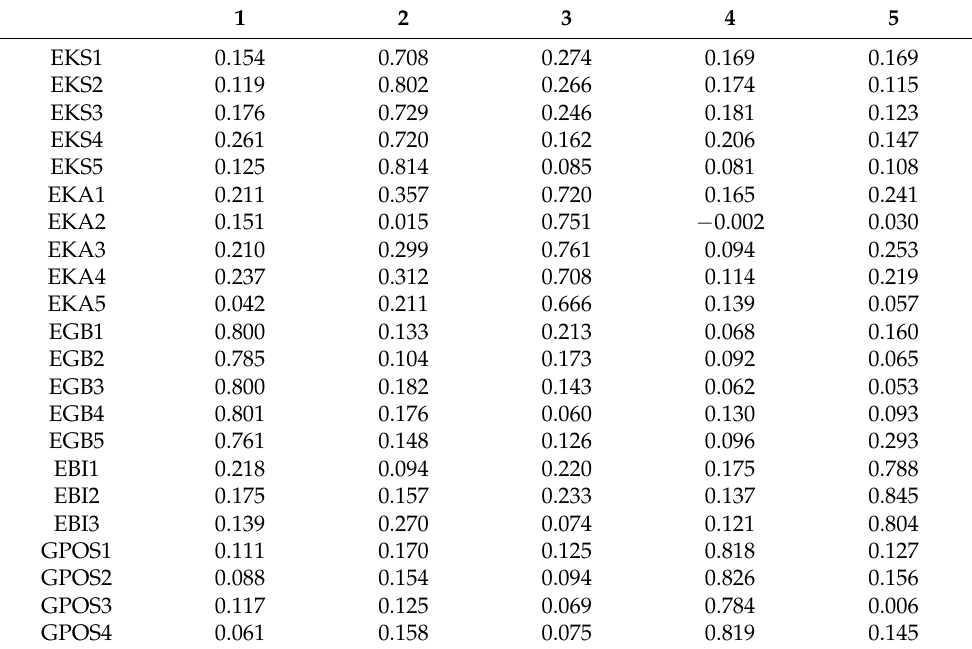
Table 3. Exploratory factor analysis results.